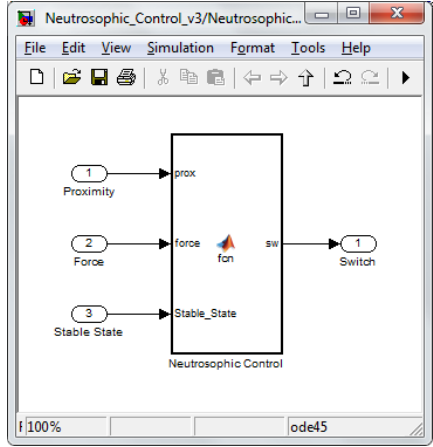
Figure 16. Neutrosophic switching diagram.